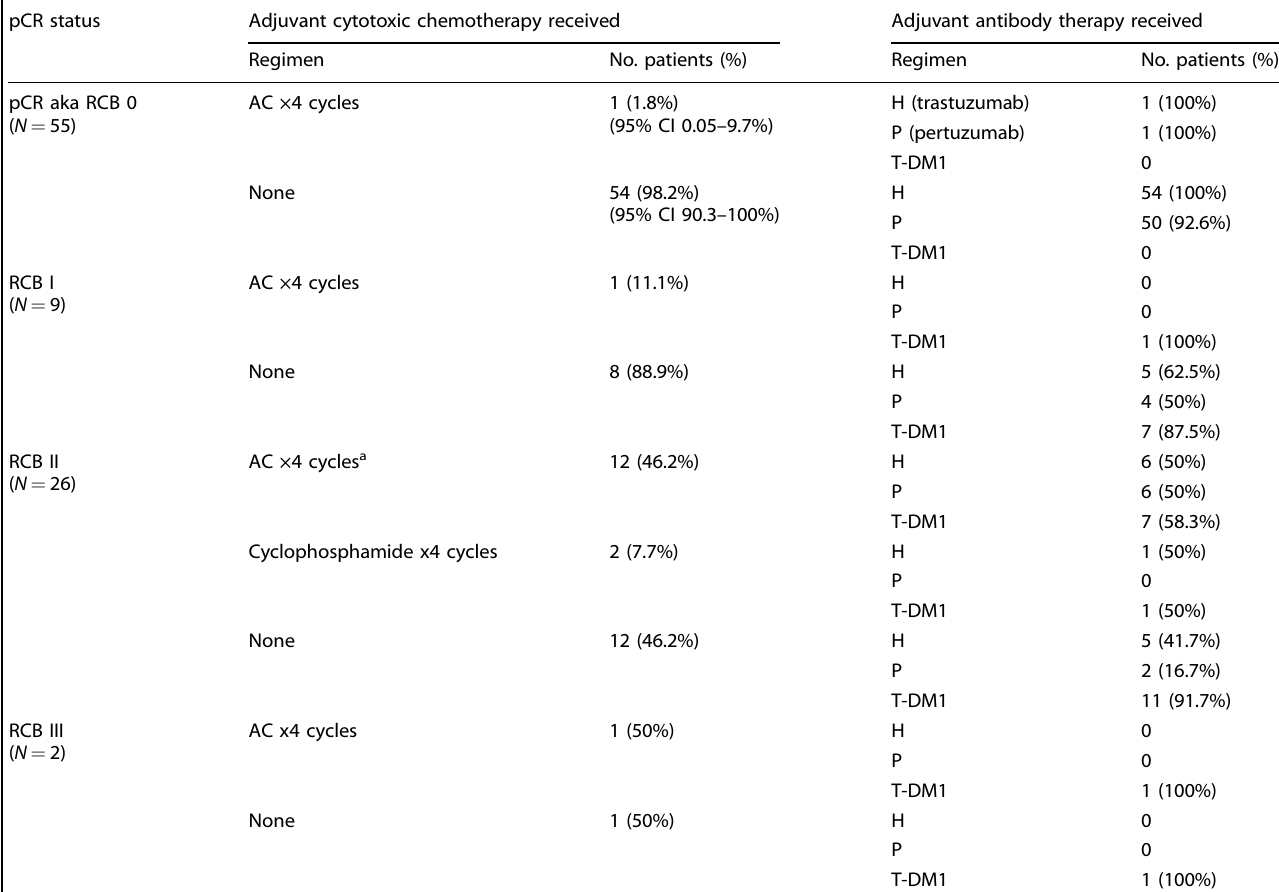
Table 2. All non-hormonal adjuvant systemic therapies